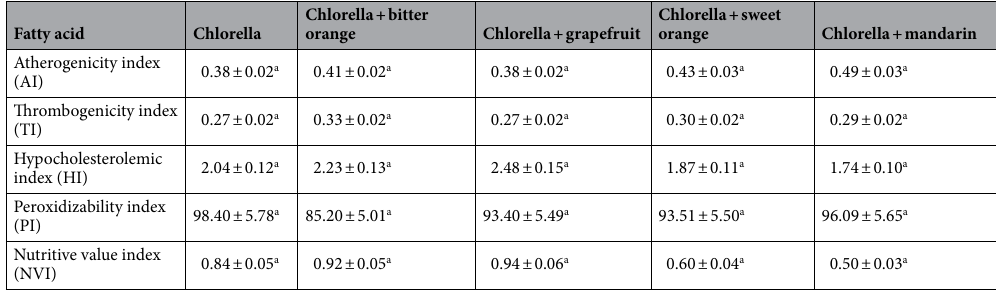
Table 4. Fatty acid composition (percent) and lipid nutritional quality of Chlorella vulgaris supplemented with of bitter orange, sweet orange, grapefruit, and mandarin peel fatty acid. The values are expressed as means plus standard deviation of three replicates. Mean values with similar letters within a row are statistically similar, while mean values with different letters within a row are significantly different by the Tukey test ( P <